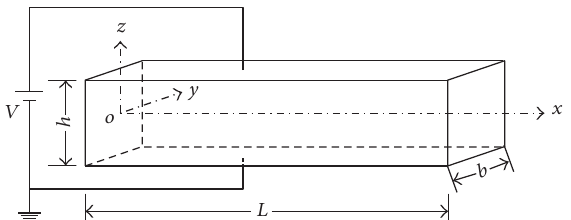
Figure 1: The schematic of the PMB whose cross section is a rectangle with width 𝑏 and height ℎ . The origin of 𝑥 , 𝑦 , and 𝑧 coordinate system is located at the geometric centre of the left end. Herein an electric field is applied between the top ( 𝑧 = ℎ/2 ) and bottom ( 𝑧 = −ℎ/2 ) surfaces. The bottom surface is